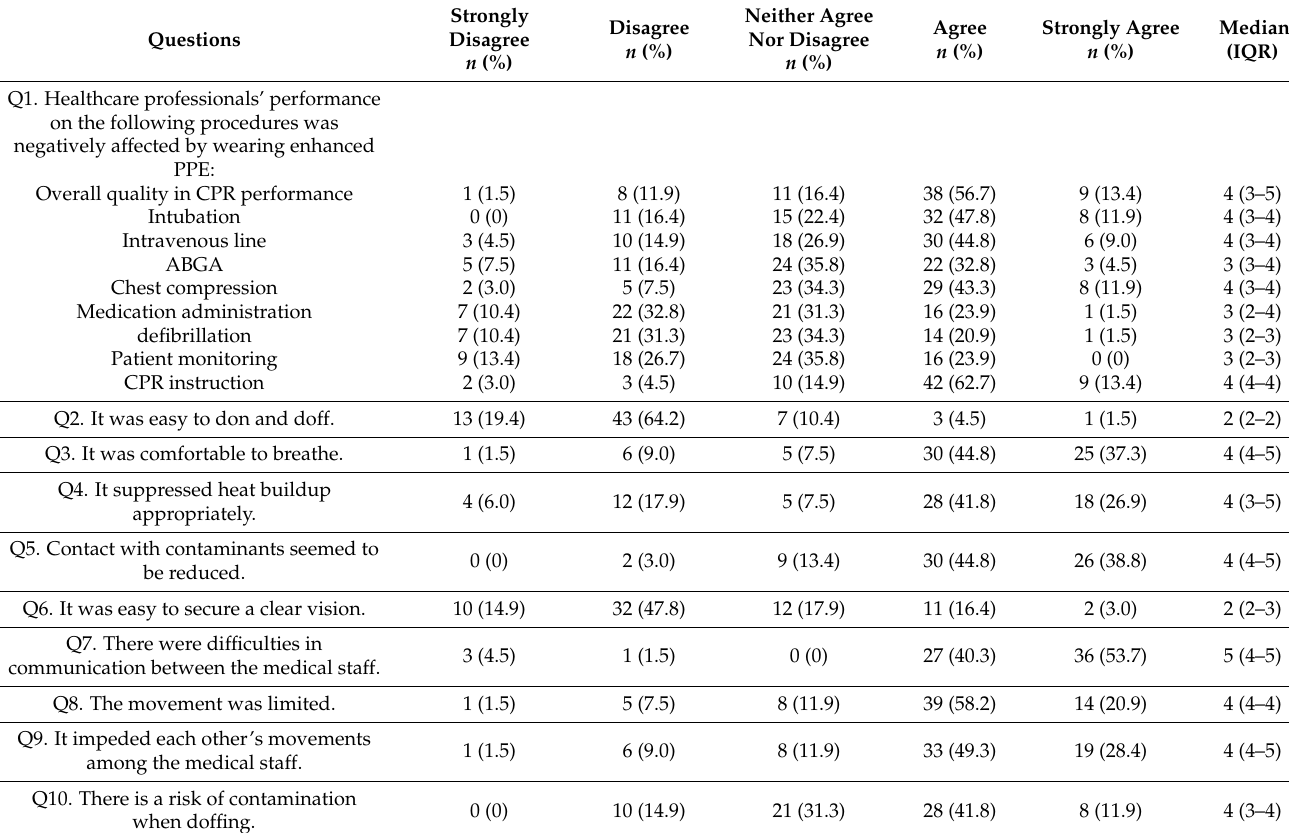
Table 3. Comparison of healthcare professionals’ perceptions between the use of enhanced and conventional personal protective